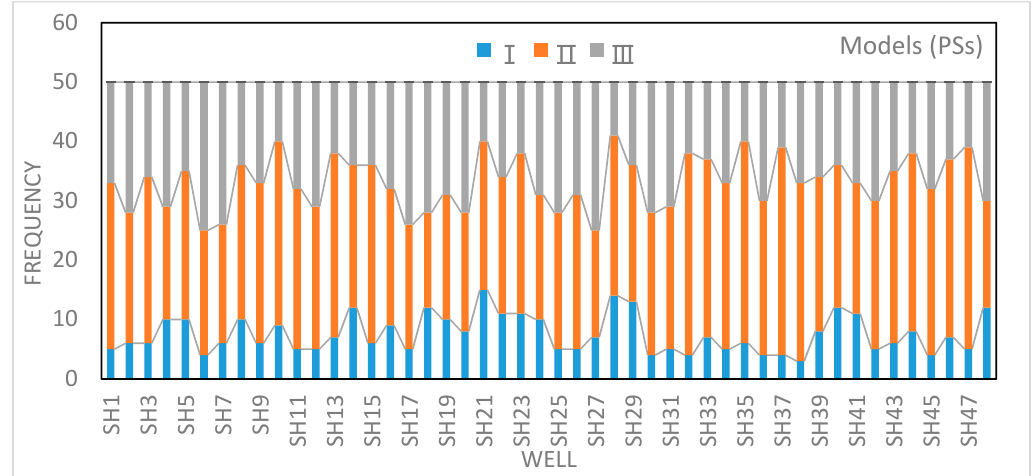
Figure 13. Statistics of comparison results of 48 horizontal wells in S6 area. These comparison results are based on the standard SIS method. Frequencies of type I and II are similar to those of models (PS). Table 5. Evaluation criterion for prediction model.